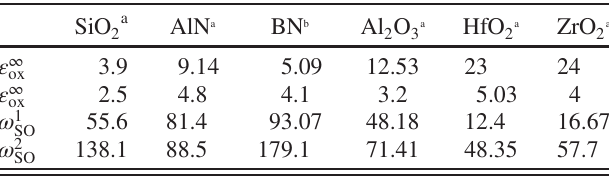
TABLE I. SO phonon modes for different dielectrics.